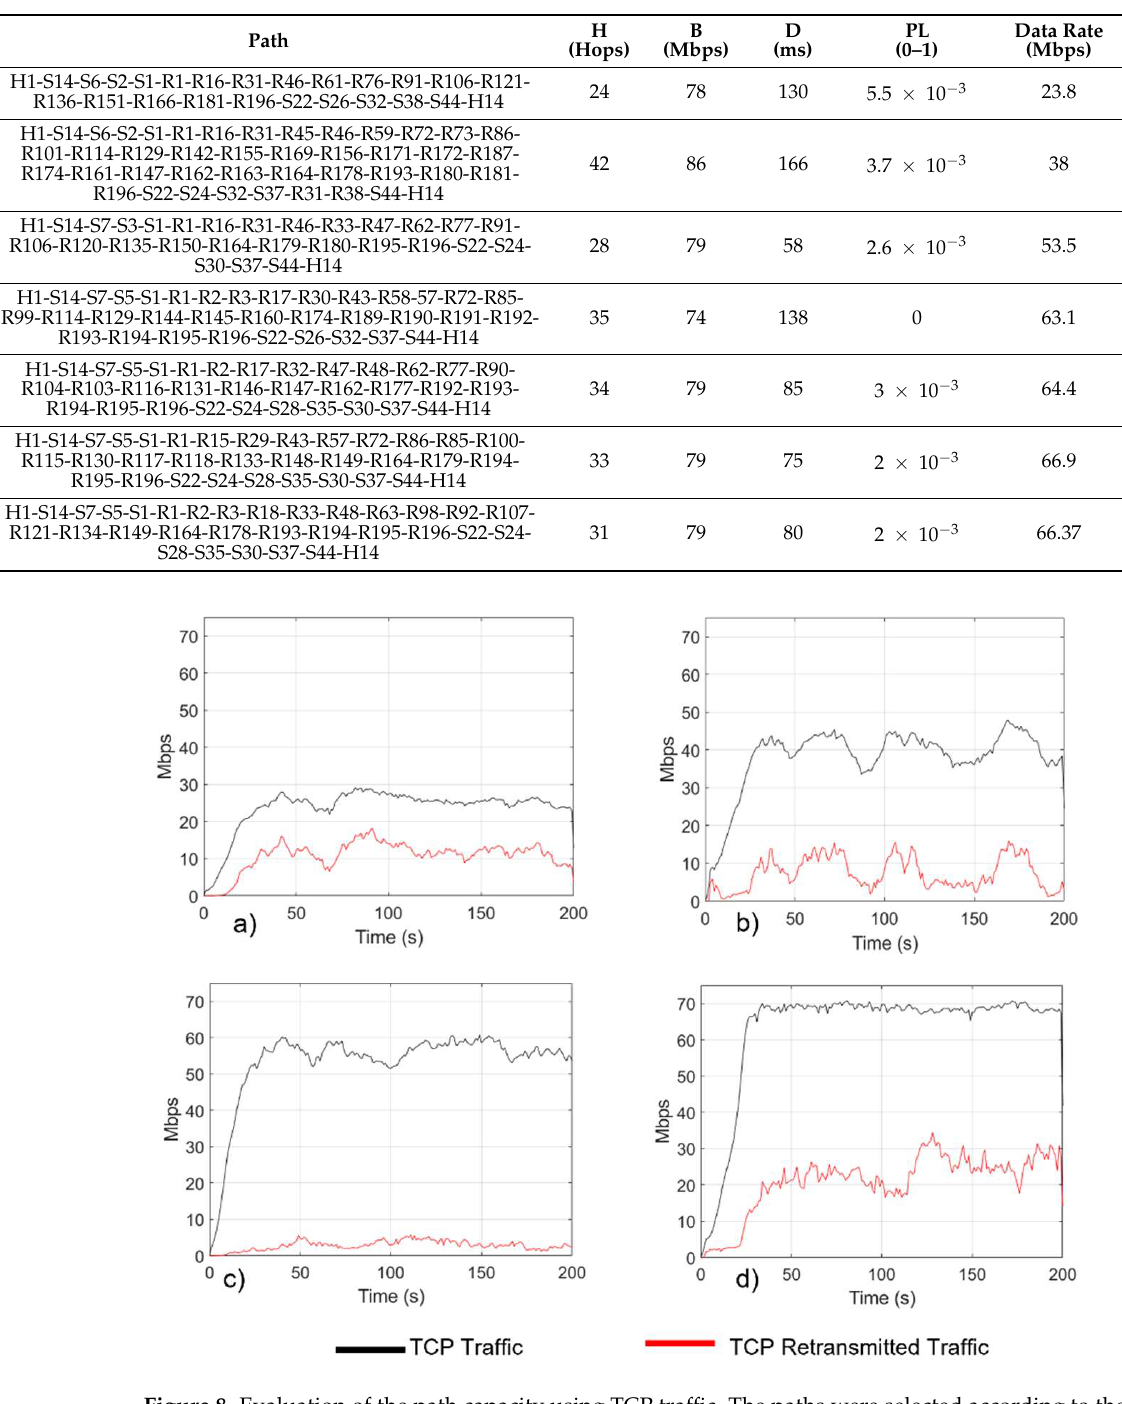
Figure 9. Evaluation of the path capacity using TCP traffic. The paths were selected according to the following multi-objective methods: ( a ) 𝑤 (cid:3003),(cid:3005),(cid:3017)(cid:3013) (weighted sum), ( b ) 𝑀𝑖𝑛 (cid:3033) (cid:3117) ,(cid:3033) (cid:3118) ,(cid:3033) (cid:3119) (MOCell), and ( c ) MOEA/D. This evaluated comparison between algorithms shows the capacity of the selected path for each. Next, we discuss each algorithm regarding the chosen path and how it affects the network performance results. As seen in Table 4, the average data transfer speeds of the traditional methods are slower (minimum hops 23.8 Mbps and maximum available bandwidth 38 Mbps) than the path selected by our method (66.9 Mbps), as were the paths with the lowest delay (53.4 Mbps) and packet loss (63.1 Mbps). For the test, we used the exact Dijkstra search algorithm to show the efficiency of different paths with optimization criteria according to the parameters usually implemented in traditional routing: fewer hops and higher bandwidth. We also added the path with the minimum delay and data loss.